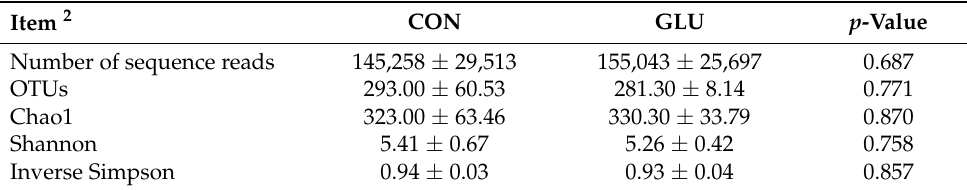
Table 8. Effects of dietary treatments on the alpha diversity of bacteria of weaned pigs 1 .